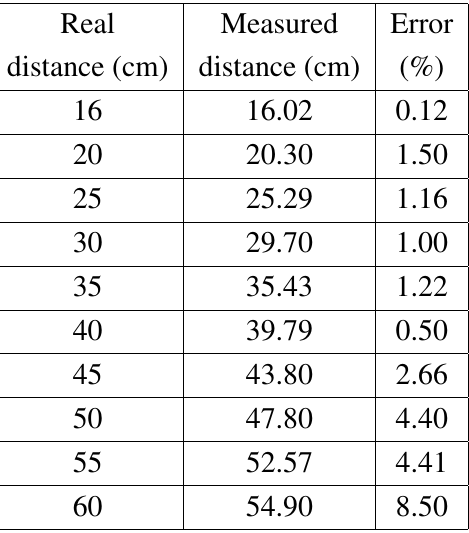
Table 6. Distance measurement results using a mobile phone